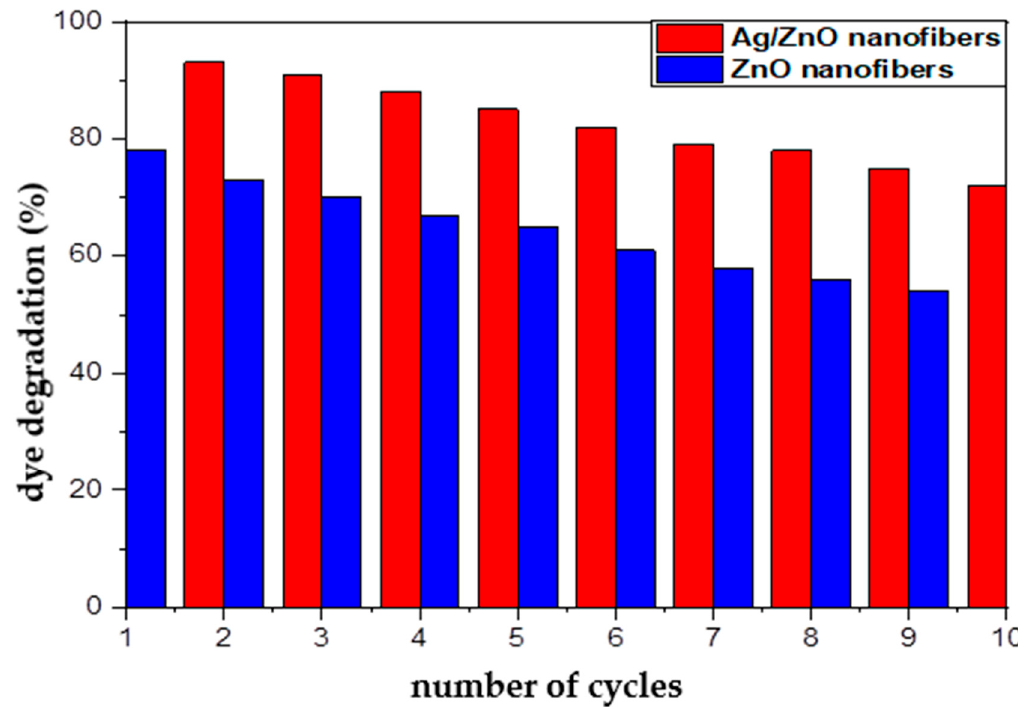
Figure 11. Reusability of ZnO polymeric composite nanofibers before and after silver immobilization as photocatalytic materials for MG dye decolorization process.